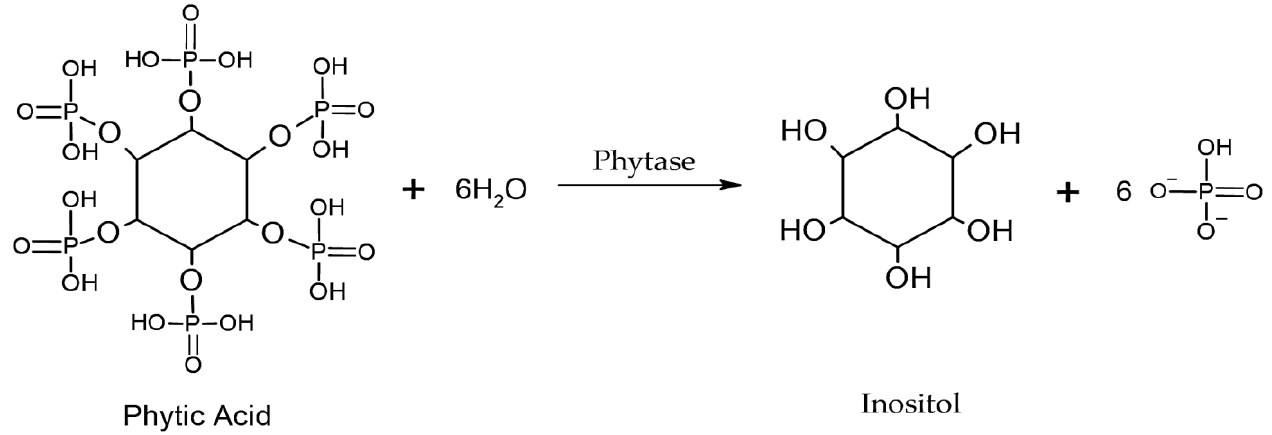
Figure 4. Phytase catalytic reaction.